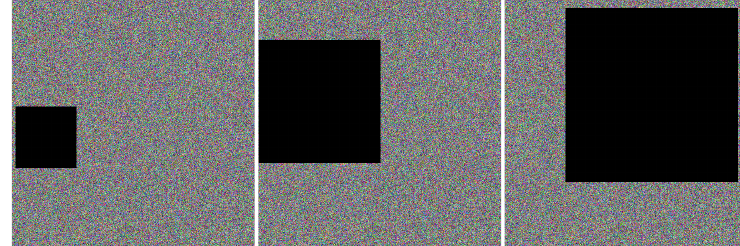
Figure 12. Sample encryption of secret image.